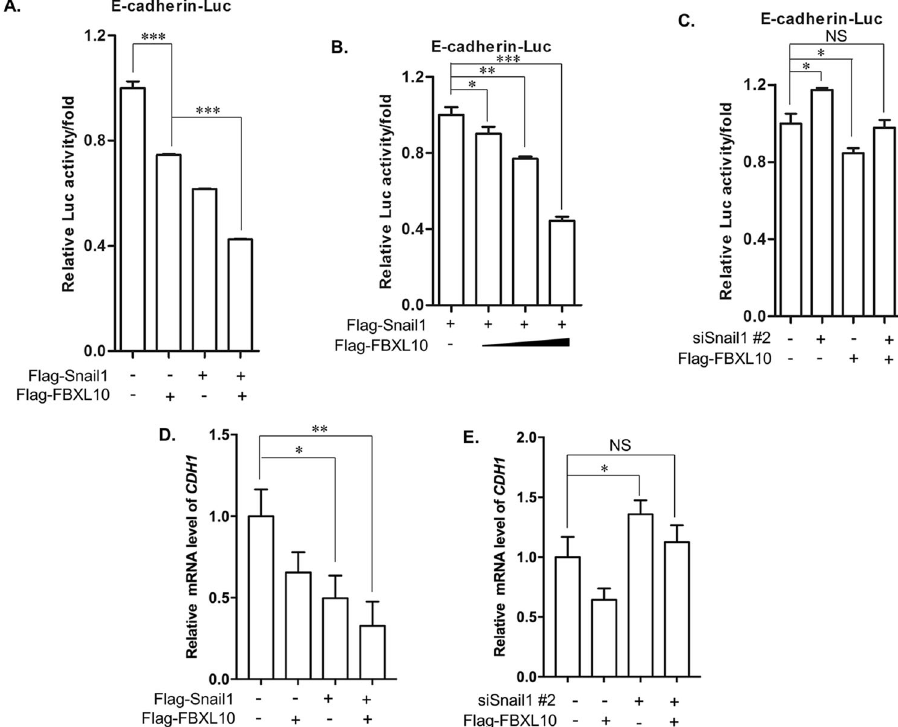
Fig. 5 FBXL10 enhanced the trans-repression of SNAI1 on CDH1 . A , B . Reporter gene assay showed the regulation of E-cadherin luciferase activity by FBXL10 and SNAI1 overexpression. * P < 0.05; ** P < 0.01; *** P < 0.001. C Reporter gene assay showed the effect of FBXL10 cooperated with or without siSNAI1 on the E-cadherin luciferase activity. D , E . qPCR assays assessed the effect of FBXL10 and SNAI1 on CDH1 mRNA levels in MCF7